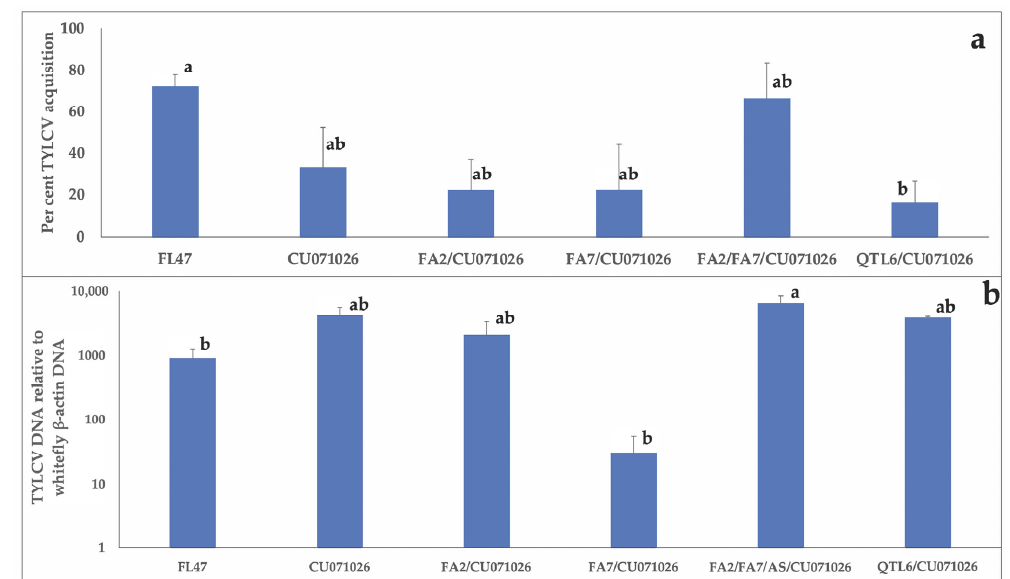
Figure 3. ( a ) Whiteflies clip-caged on tomato leaflets of acylsugar-producing lines and FL47 for 72 h were individually tested for the presence or absence of TYLCV using endpoint PCR. The treatment means were separated using the Tukey–Kramer method following analysis of variance. Di ff erent letters within the column indicate di ff erences among treatments. ( b ) Bars represent averages of TYLCV loads with standard errors in relation to the whitefly housekeeping gene ( β -actin) DNA in individual whiteflies following acquisition from acylsugar-producing lines and FL47 DNA extracted from TYLCV positive whitefly samples (n = 3 to 13 / treatment) as determined by endpoint PCR alone were used for quantitative PCR. The treatment means were separated using the Tukey–Kramer method following analysis of variance. Di ff erent letters within the column indicate di ff erences among